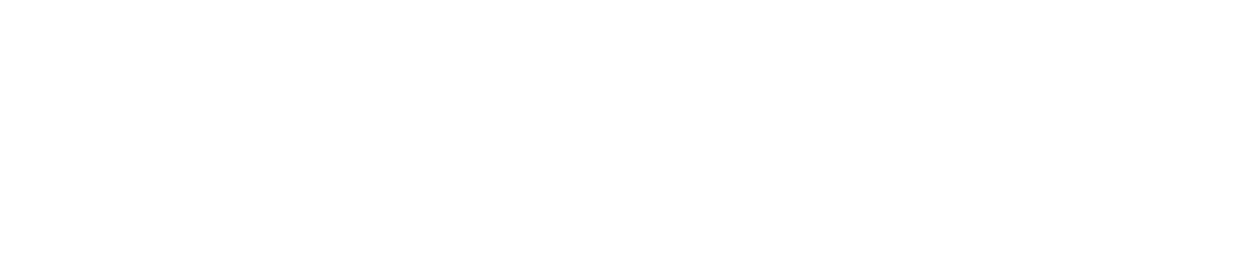
Frontiers in Medicine |